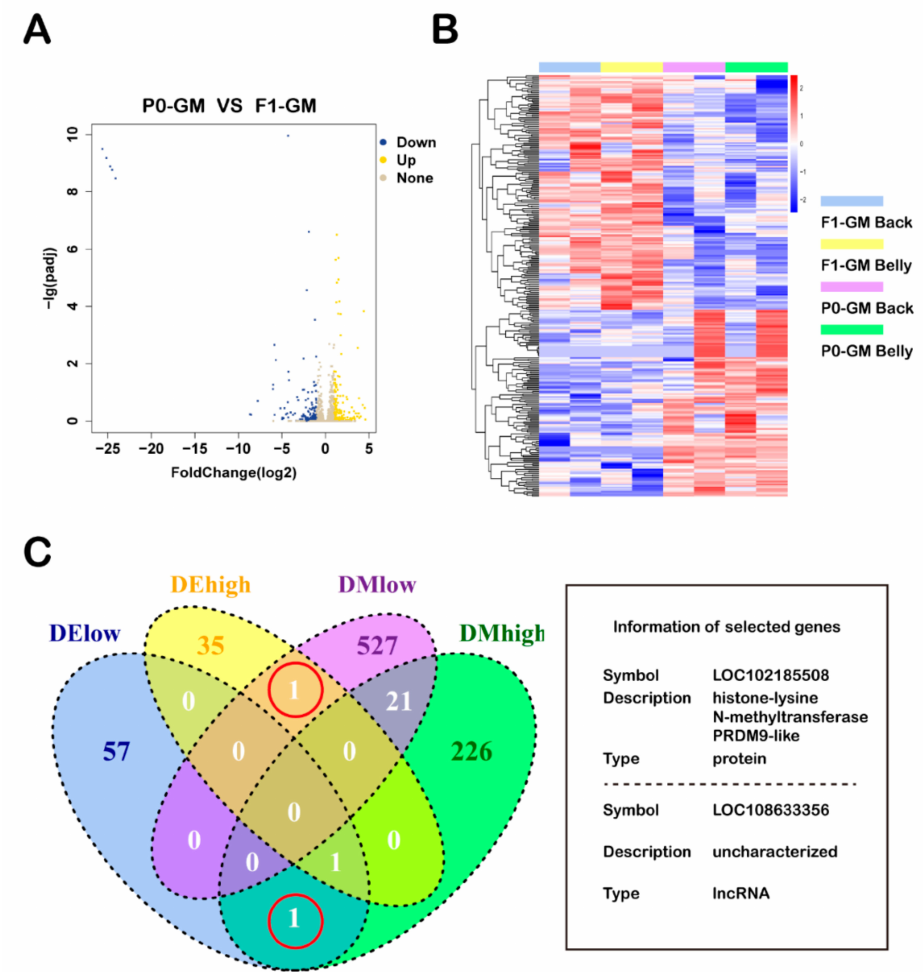
Figure 5. Transcriptional level profiles for the skin samples of cashmere goats and an integrative analysis of the methylation and transcriptional profiles. ( A ) A volcano plot of all genes in the skin samples from the P0-GM and F1-GM cashmere goats; showing genes with > 2-fold di ff erence and an adjusted p < 0.01 among groups; P0-GM, the two parents (a female and a male from P0 for an generational methylation study); F1-GM, their twin o ff spring (from F1-2-NM for an generational methylation study). ( B ) The heat map of gene expression profiles in the skin samples from the P0-GM and F1-GM cashmere goats. The colored bars illustrate relative expression. In the map, each sample group is clustered. Skin samples were taken from the back and belly of cashmere goats. ( C ) A Venn diagram illustrating a comparison of di ff erentially methylated genes and di ff erentially expressed genes. The red circles represent the genes selected. The box shows information about the genes selected. DE-high, the di ff erentially expressed genes (DEGs) of high expressed; DE-low, the DEGs of low expressed; DM-high, di ff erentially methylated regions (DMRs) of hypermethylation; DM-low, DMRs of